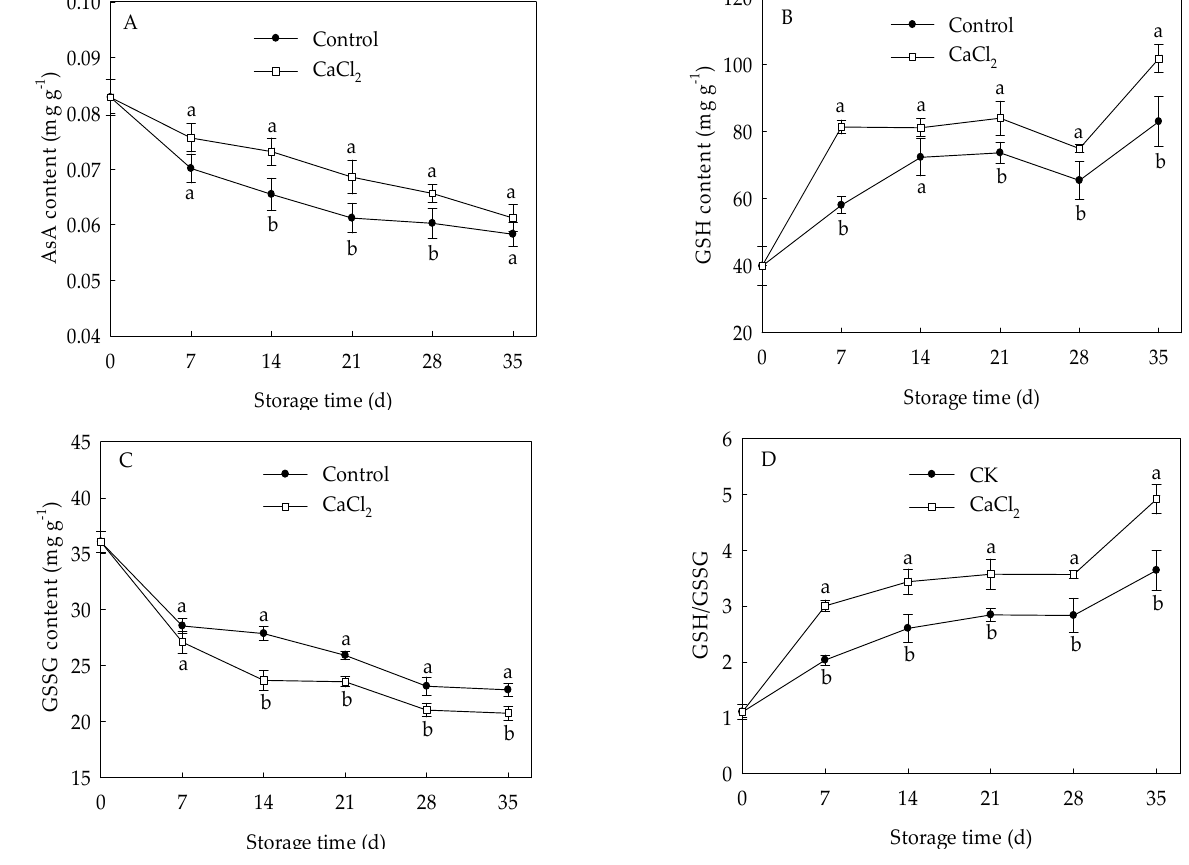
Figure 5. AsA ( A ), GSH ( B ), GSSG ( C ) contents and GSH/GSSG ( D ) in loquat fruit stored at 1 °C after treatment with 1% CaCl 2 or water (control). Vertical bars indicate the SE of mean ( n = 3). The symbols a and b represent a significant difference in the two treatments ( p < 0.05).